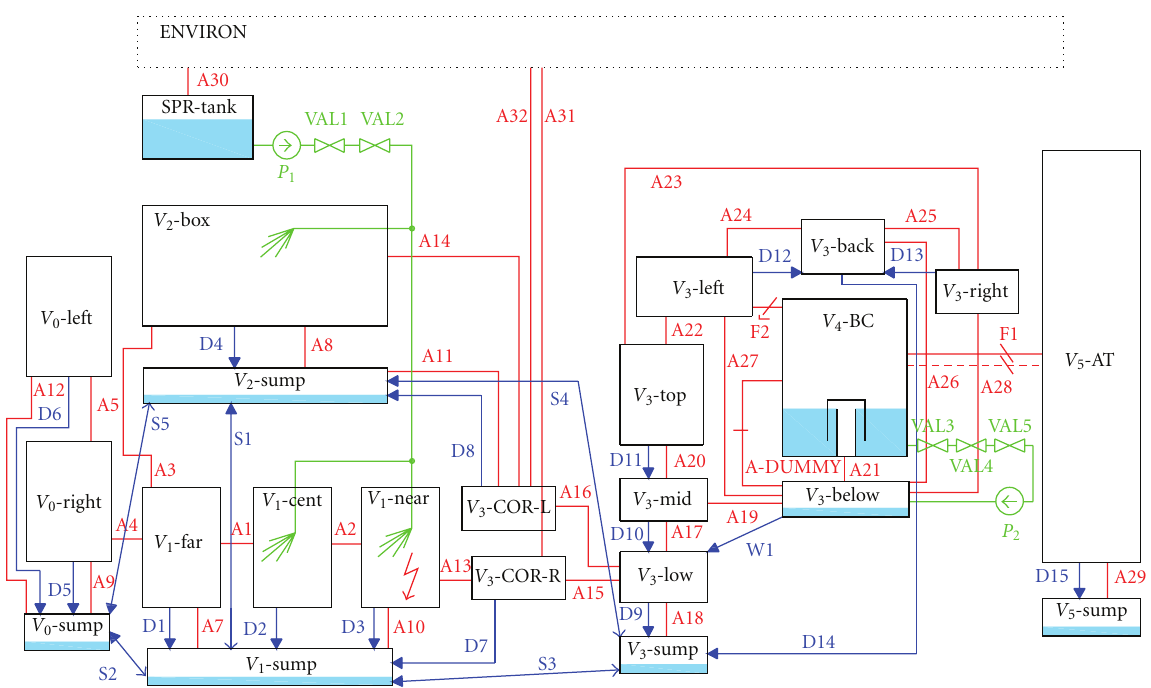
Figure 8: COCOSYS, 24 zone nodalization for the EREC BC V-213 test